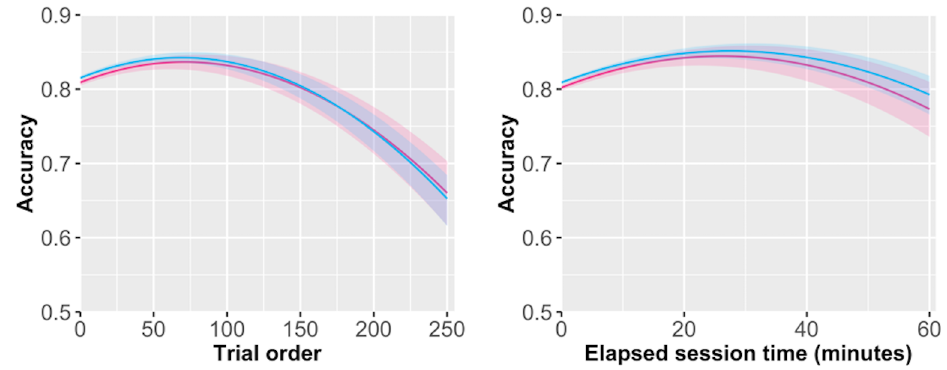
Fig 3. Quadratic regression of accuracyon trial length. Notes: Red = sample 1, Blue = sample 2. Average regression effect of (A) trial numberand (B) elapsedtime on accuracy. Shadedregions represent the 95% CI of the fixed